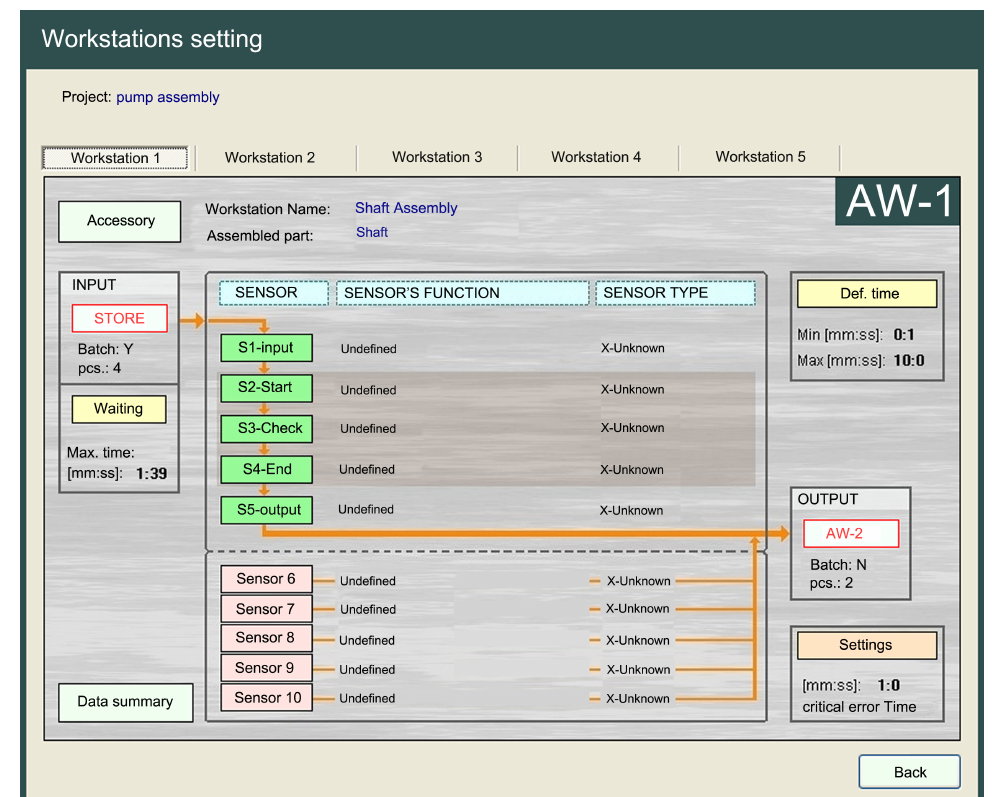
Figure 5: Screenshots of software for manual assembly on-line